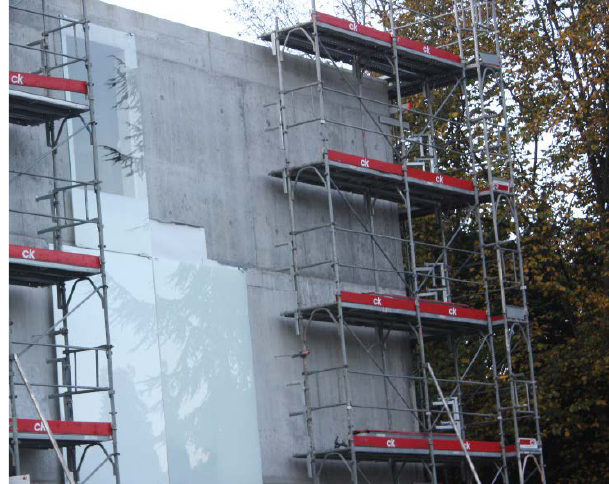
Fig. 8: First prototype, colors, aspect, translucency and reflectance